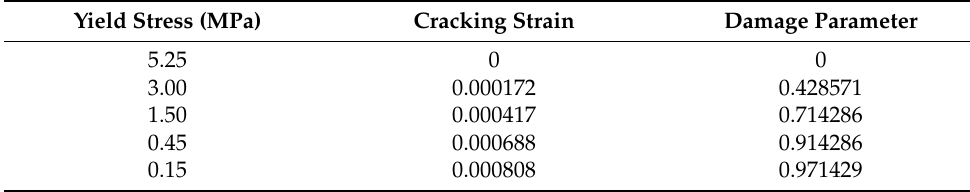
Table 4. Tensile input parameters of